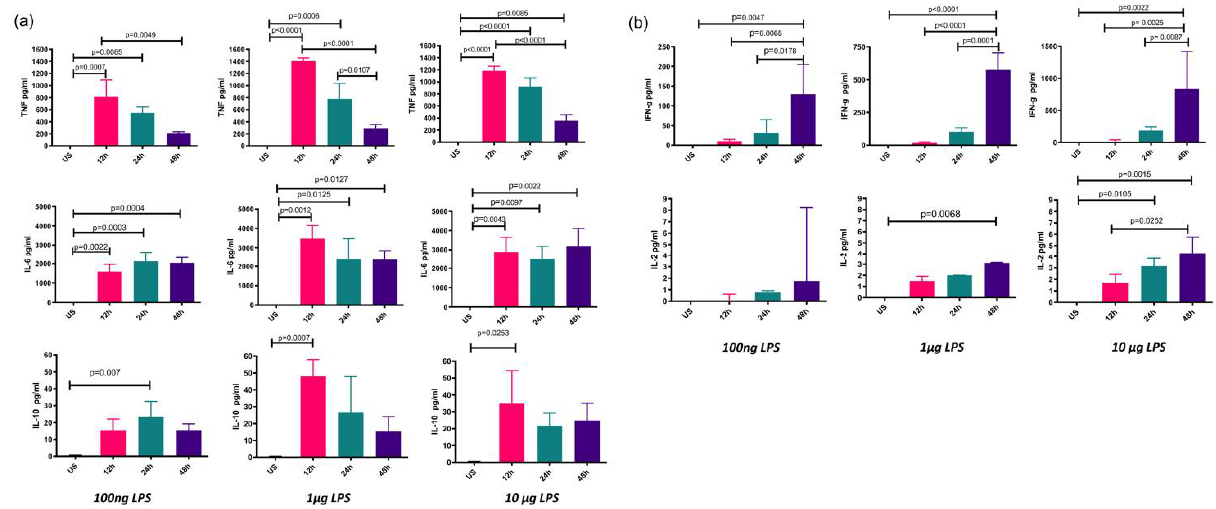
Figure 4. Soluble cytokine production kinetics. Mo-DCs from healthy donors were stimulated for 12, 24, or 48 h with 100 ng, 1 µ g, or 10 µ g of LPS or were left unstimulated (US). The supernatant was collected and assessed for soluble cytokines ( a ) TNF- α , IL-6, IL-10, ( b ) IFN- γ , and IL-2, as described in the material and methods. The mean ± SD of 3 independent assays performed in triplicate is depicted in the graphs.